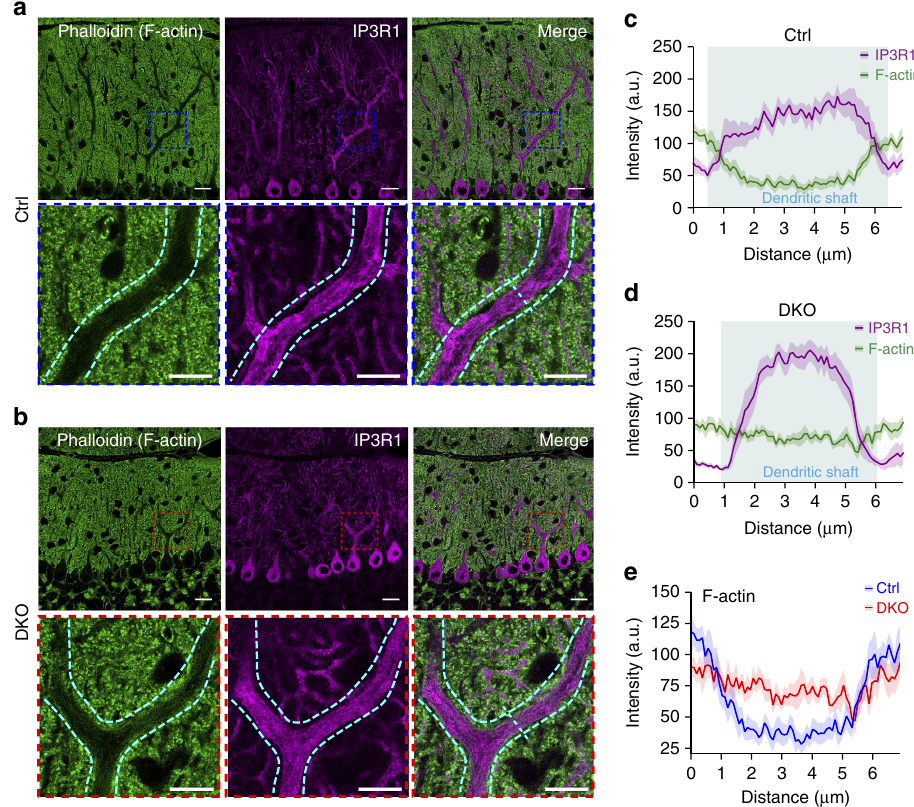
Figure 5 | Distorted F-actin localization in the PCs of DKO mutants in vivo . ( a , b ) Immunostaining of IP3R1 (magenta) and phalloidin staining (green) in the cerebellum sections from the controls ( a ) and the DKO mutants ( b ). Phalloidin (green) stained the F-actin cytoskeleton while IP3R1 (magenta) marked PCs. Lower panels are the zoom-in images of boxed regions respective to the upper panels. Only the central focal planes of the PC proximal dendrites are shown here. Cyan dotted curves highlight the peripheries of the dendritic shafts of the proximal dendrites. Scale bars, 20 m m; 10 m m (zoom-in). ( c – e ) Fluorescence intensity profile plots (across the dotted cyan lines) reveal the distribution of F-actin in the dendritic shafts of the proximal dendrites in the PCs from the controls ( c ) and the DKO mutants ( d ). Areas shaded in cyan represent the dendritic shafts. Each profile plot was sampled from 10 different PCs from 4 different mice and the curves represent mean ± s.e.m. Note the altered distribution of F-actin in the centre of dendritic shafts in the PCs of the DKO mutants in vivo ( e